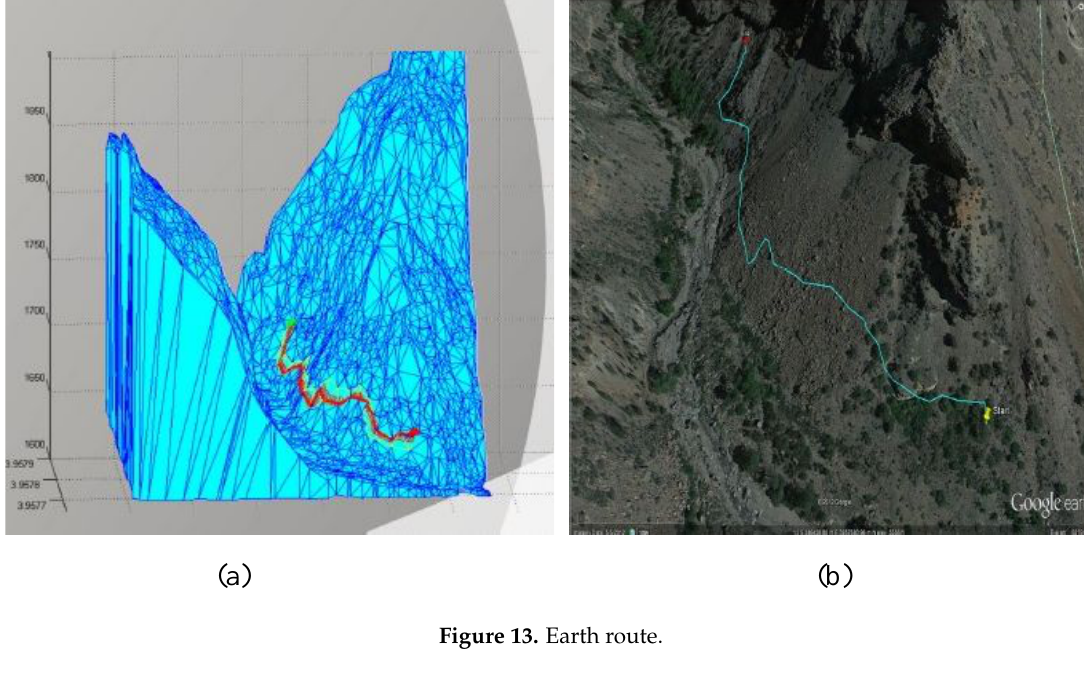
Figure 13. Earth